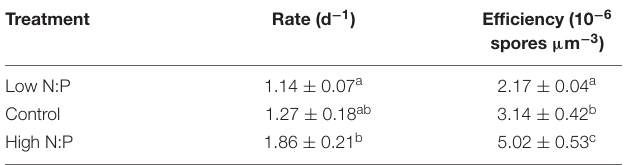
TABLE 4 | Zoospore production rates and production efficiencies (mean ± SE).